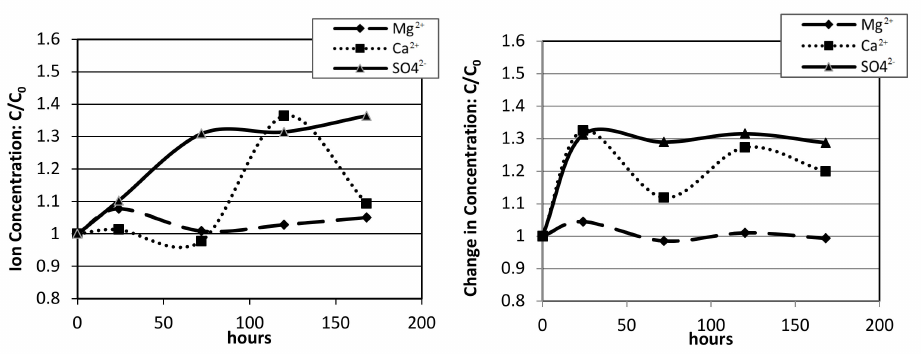
Figure 2. Change of Potential Determining Ions concentration during aging of an oil-saturated rock ( left ) and a clean rock ( right ) with Low Salinity Water (5 × Diluted